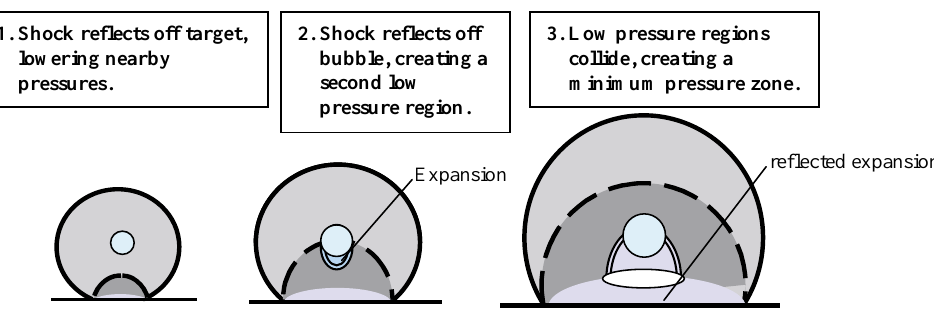
Fig. 3. Close-in fluid-structure interaction for a deforming